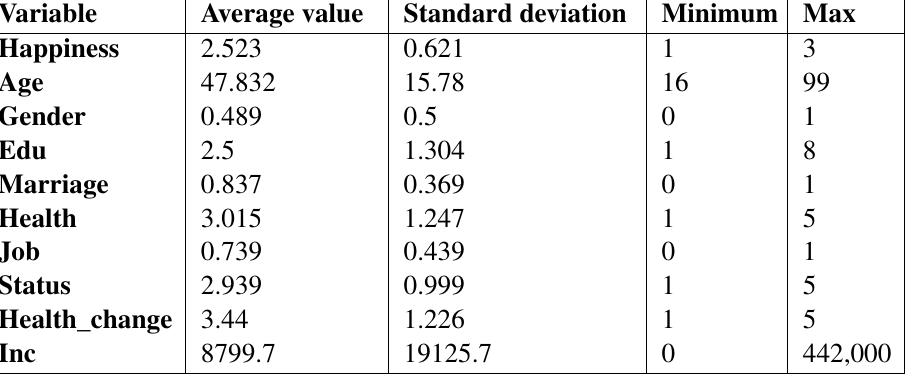
Table 1 Descriptive statistics of each